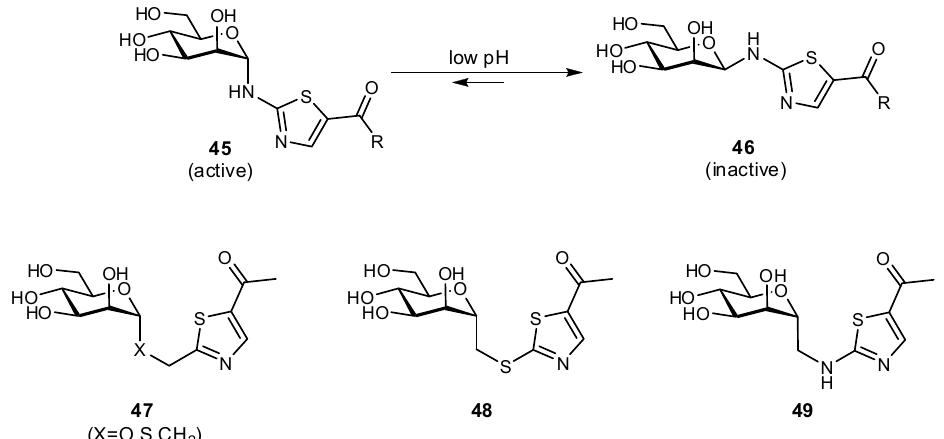
Figure 15. A comparison of O -, N -, S -, and C -glycosides as FimH antagonists for therapy in Crohn’s disease [116,117,119] .